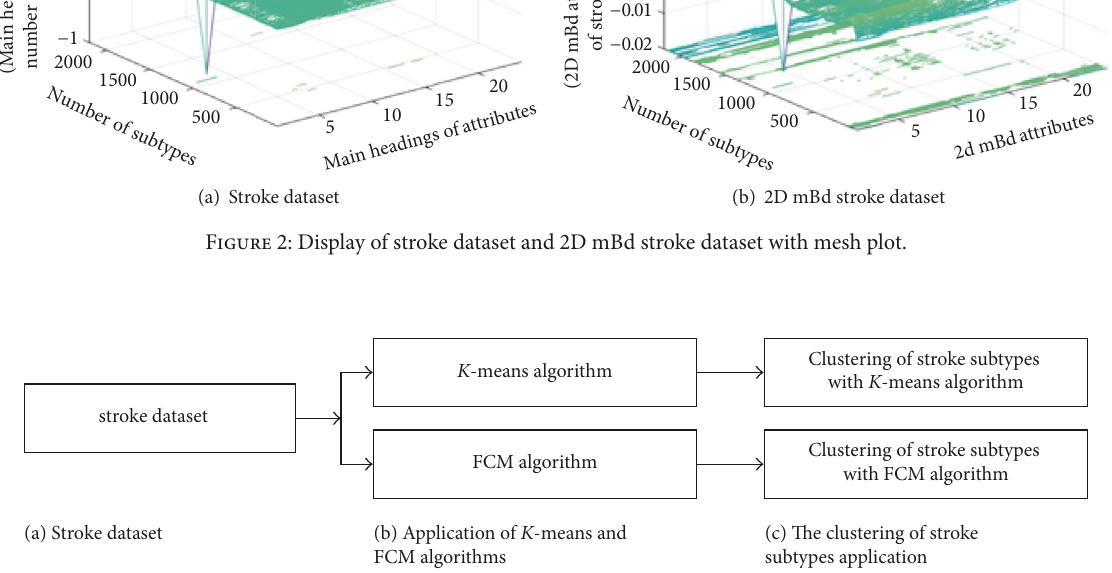
Figure 3: The application of the 𝐾 -means and FCM algorithms to the stroke